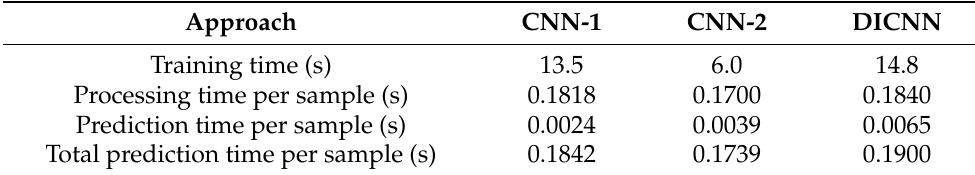
Table 12. Time taken by each model for different